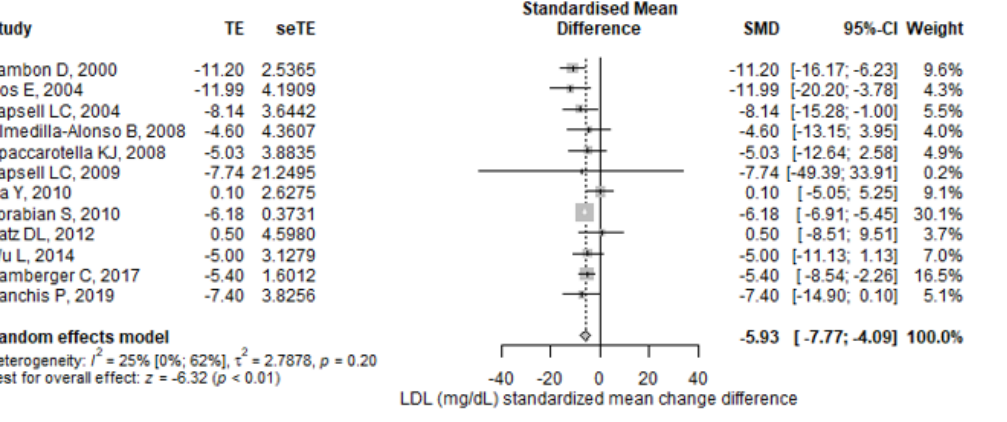
Figure 5. Forest plot for LDL cholesterol (mg/dL) standardized mean change difference. TE — treatment effect; seTE — the standard error of the treatment effect; SMD — standardized mean difference; CI — confidence interval.